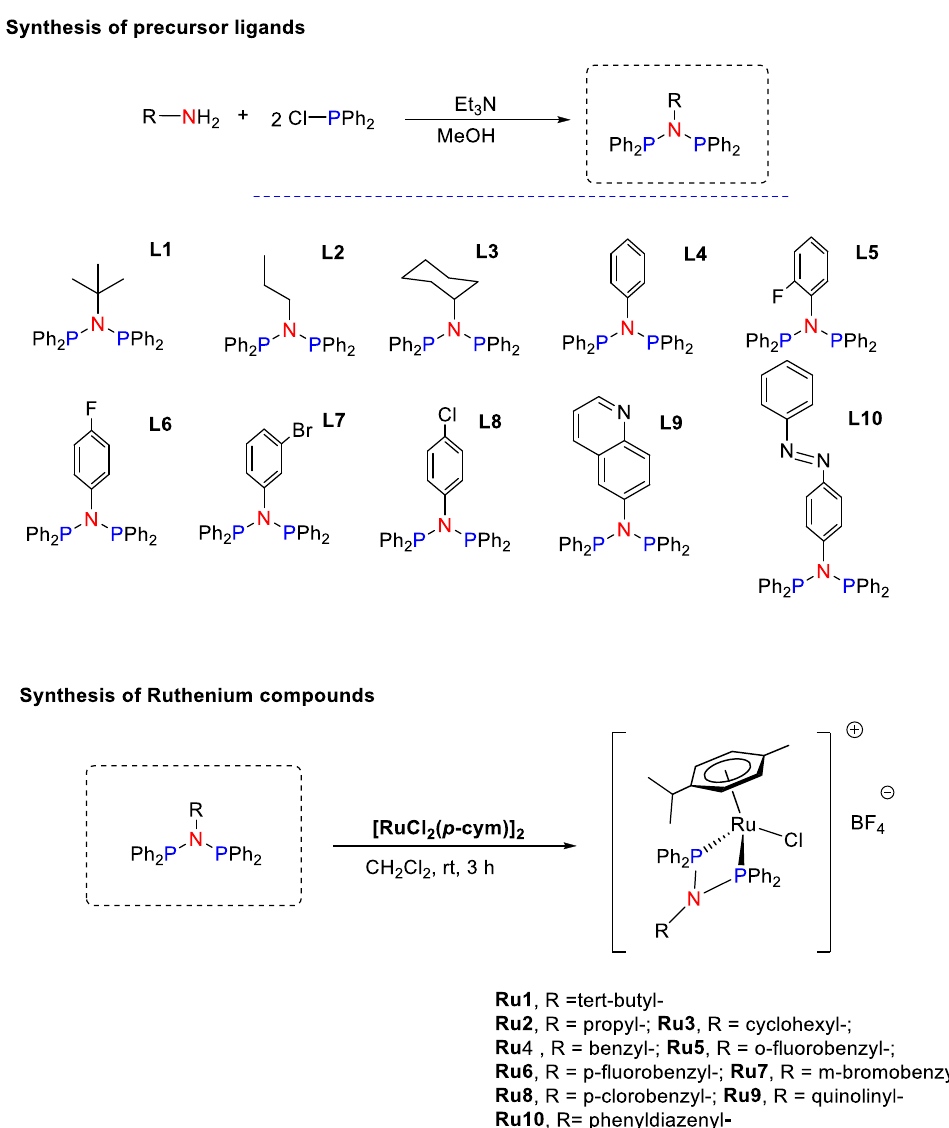
Figure 2. Synthesis of precursor ligands L1 – L10 and ruthenium compounds Ru1 – Ru10.